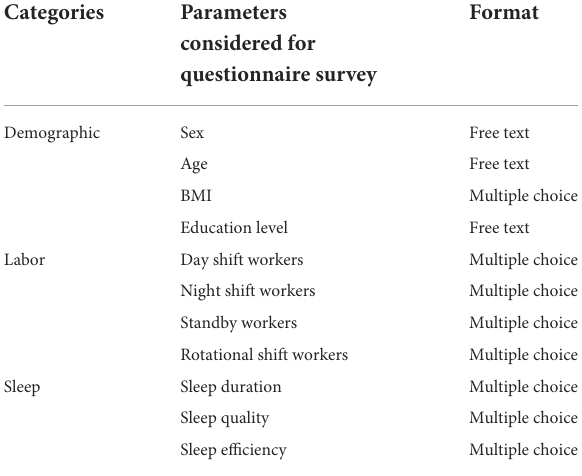
TABLE 1 Parameters and format for questionnaire survey. TABLE 2 Demographical information of the body mass index (BMI) and ages of laborers in various